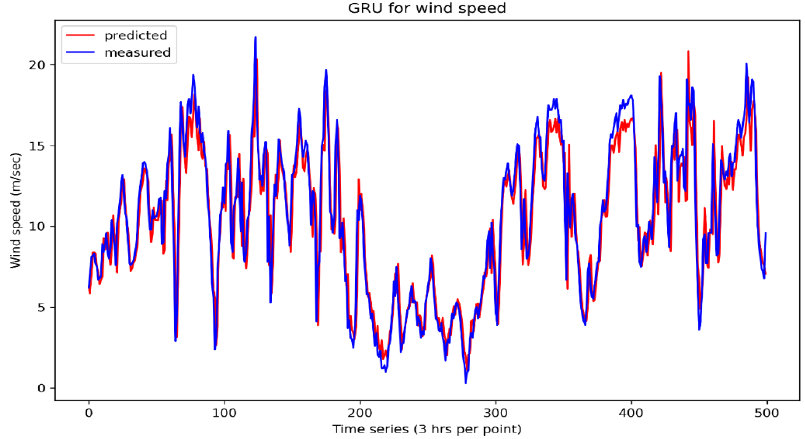
Figure 19. GRU wind speed prediction.